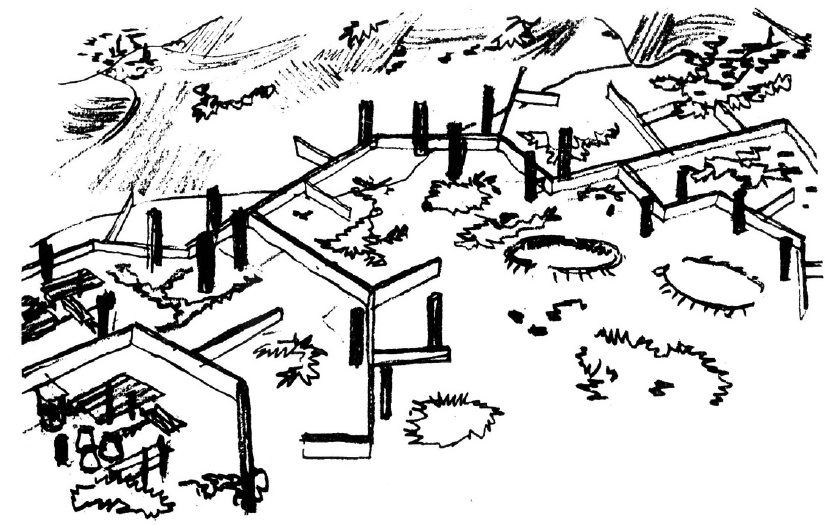
Figure 10. Golden Lane competition project panel, 1952, showing continuous interconnected housing blocks surrounded by green spaces. Presented on a CIAM Grid, CIAM 9, Aix-en-Provence. Source: Smithson and Smithson